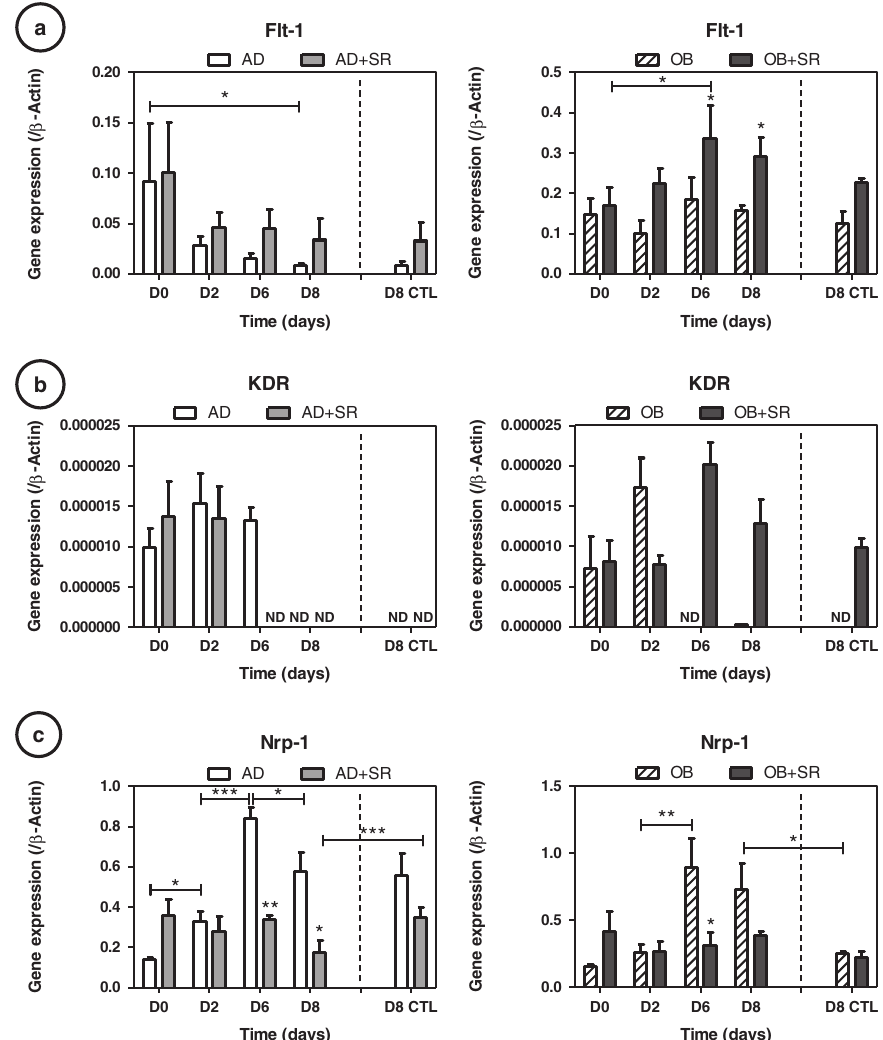
Fig. 5 Strontium (SR) downregulates Nrp-1 receptor expression: a VEGF receptor 1 (Flt-1), b VEGF receptor 2 (KDR) and c neuropilin 1 (Nrp-1) gene expressions were measured at days 2, 6 and 8 by RT-quantitative PCR during the cultures in adipogenic (AD) or osteogenic (OB) media, with or without 5 mM strontium. Day 8 of control static condition corresponds to the D8 CTL data. Error bars represent S.E.M. * p < 0.05, **p < 0.01 and ***p < 0.001 compared to media without strontium or compared with conditions indicated by the horizontal bars ( N =